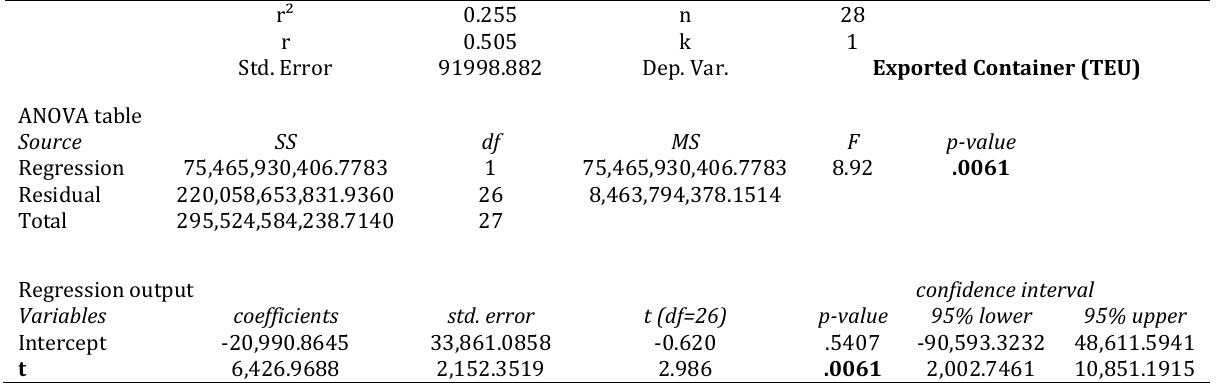
Table 6: Regression Analysis: Trend Analysis of Exported Containers (Trendline Curve Fit)